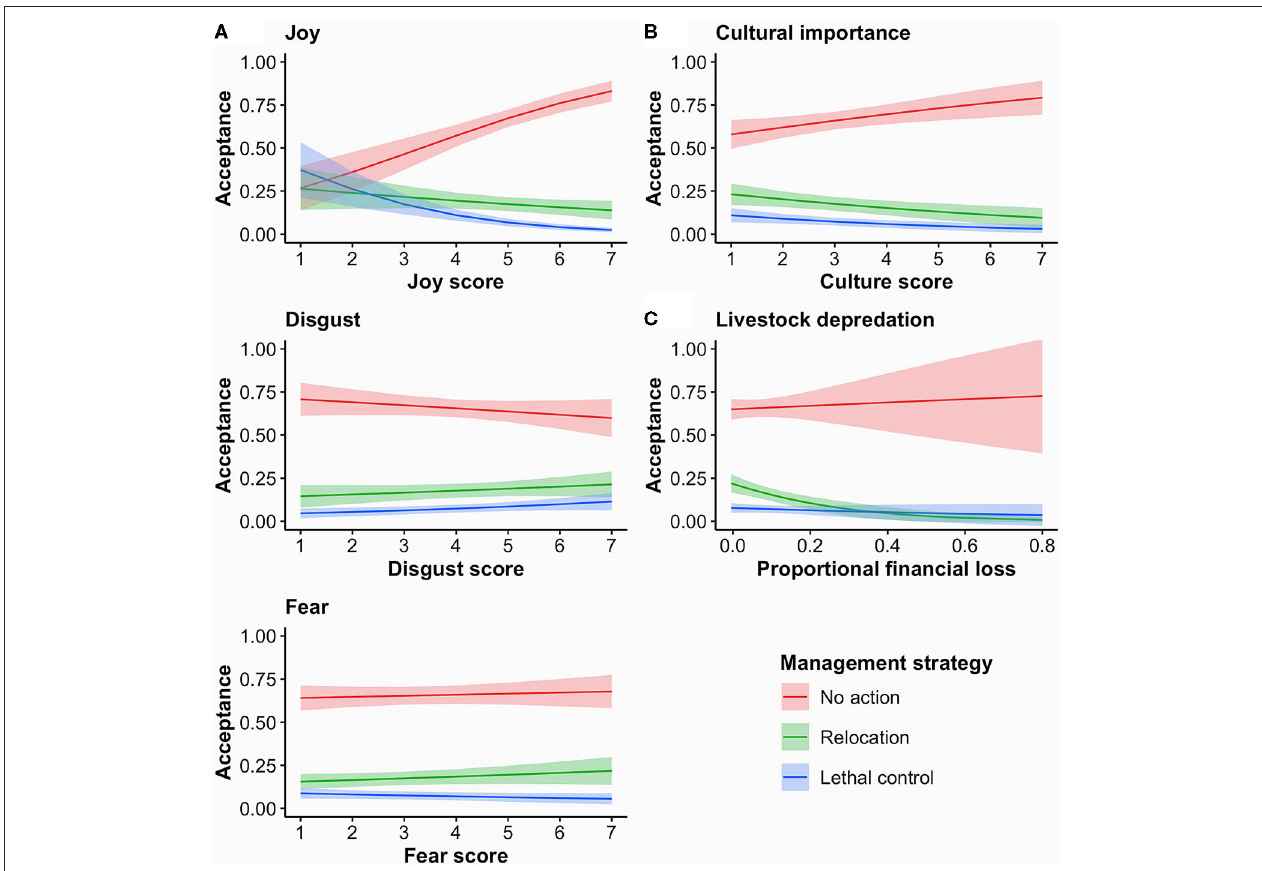
FIGURE 4 | Cumulative predicted probability of the acceptance (score > 4) of no action, relocation, and lethal control as management strategies toward hyenas, lions, and leopards by Maasai pastoralists in Ngorongoro Conservation Area, Tanzania. Plots show how emotions (A) , cultural importance (B) , and livestock depredation (C) influenced the acceptance of the management strategies. For emotions and cultural importance, scores range from 1 (strongly disagree/reject) to 7 (strongly agree/accept), with 4 representing a neutral score. For livestock depredation, the x-axis is limited to the range of observed values (0.0–0.8). Lines represent mean predicted probabilities from an ordinal logistic regression model and shading represents the 95% confidence intervals when continuous predictors are held at their population means and using the mean effect of the carnivore